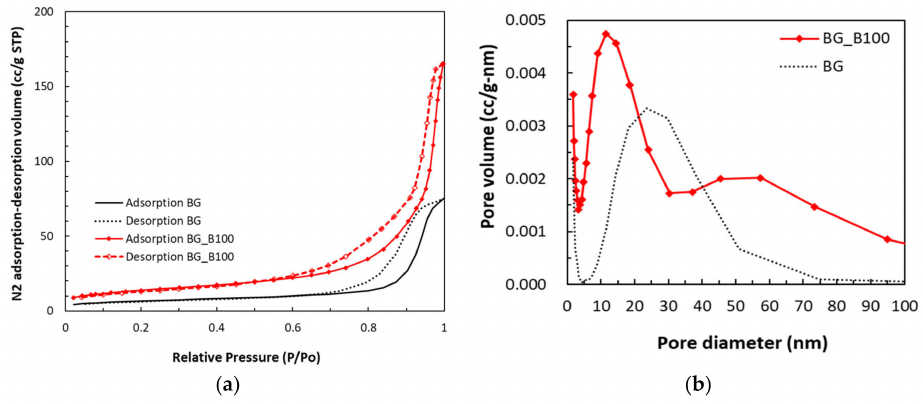
Figure 4. ( a ) N 2 adsorption–desorption isotherms and ( b ) pore size distribution of BG and B-doped BG.